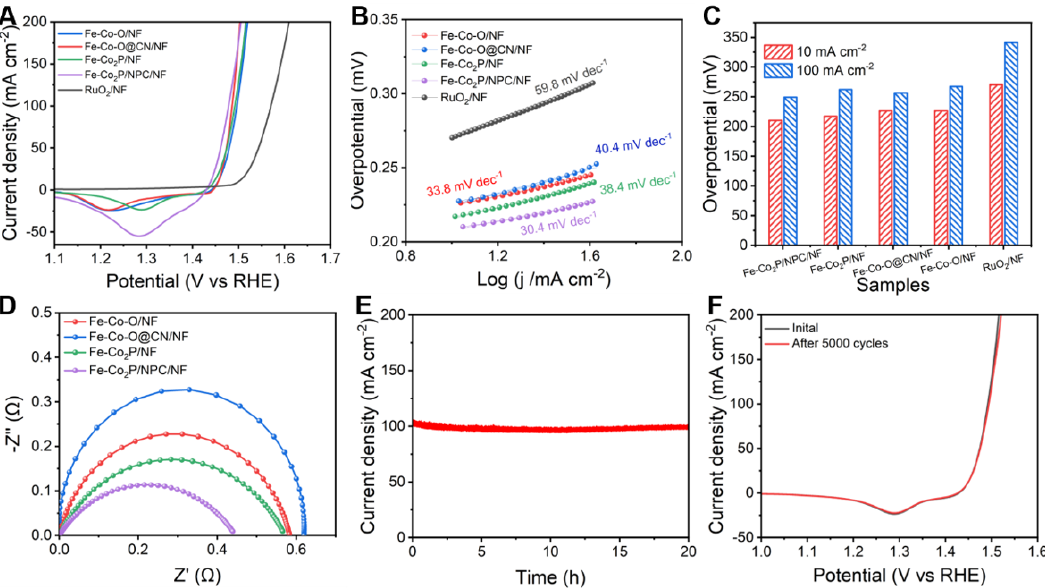
Figure 4. OER performances of different catalysts. ( A ) Polarization curves, ( B ) Tafel slope, ( C ) overpotentials, and ( D ) EIS Nyquist plots of different catalysts. ( E ) Chronoamperometry curve of Fe-Co 2 P/NPC/NF. ( F ) Polarization curves of Fe-Co 2 P/NPC/NF before and after stability testing.